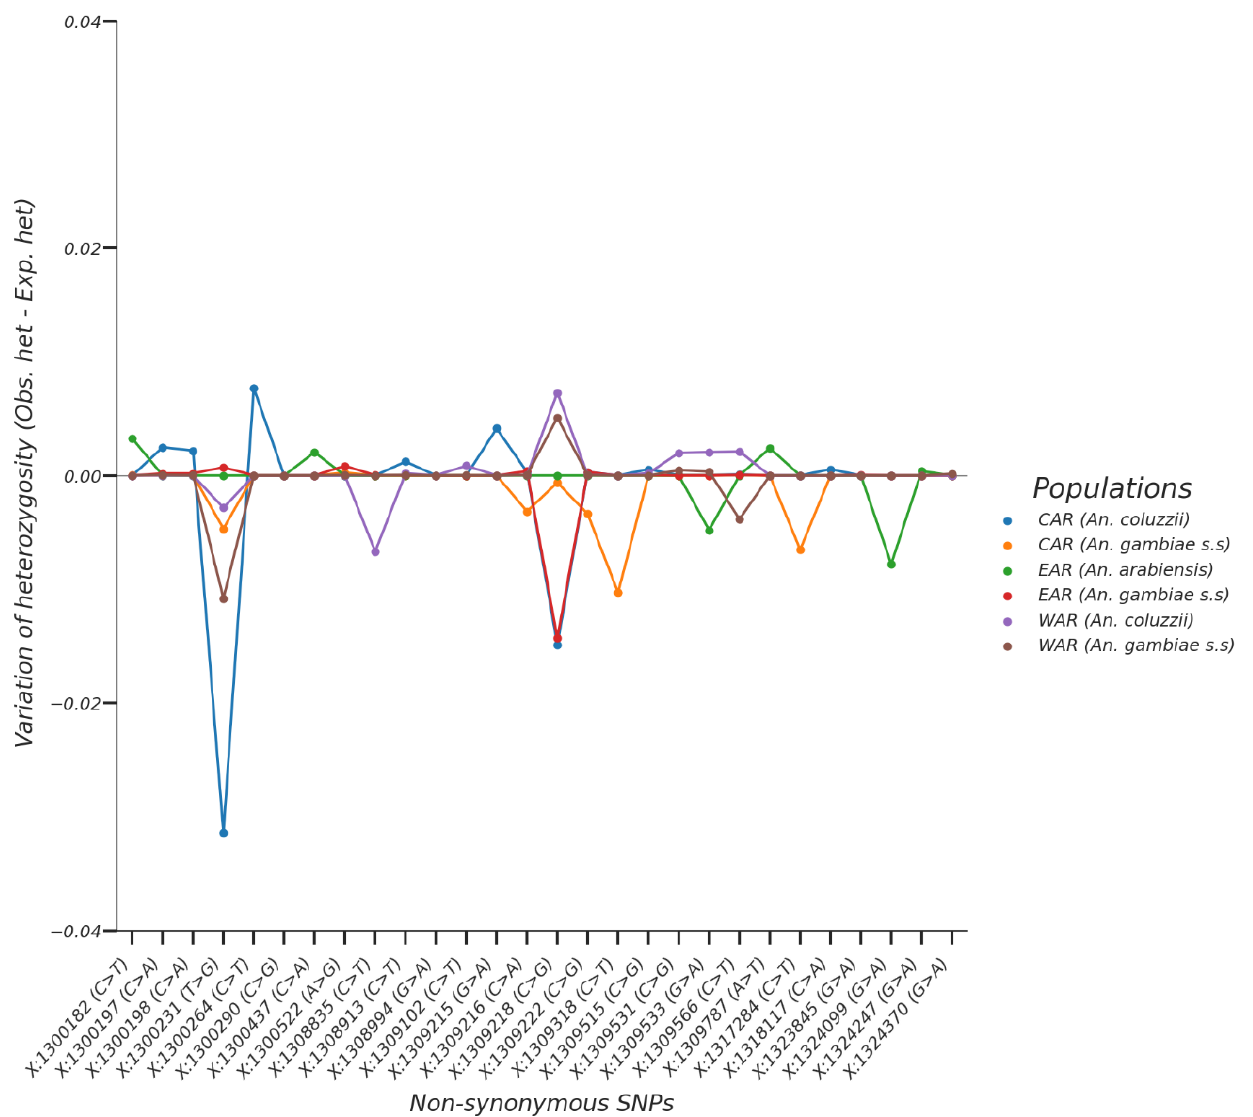
Figure 2. Variation of the heterozygosity within the non-synonymous SNPs with maximum allelic frequencies that are superior to 5% in at least one population of An. gambiae complex from West, Central, and East Africa. The vertical axis shows the difference between the observed and the expected heterozygosity; the horizontal axis shows the non-synonymous SNPs positions. Positive values (Obs. het > Exp. het) mean an excess of heterozygotes at this position; negative values (Obs. het < Exp. het) mean a deficit of heterozygotes at this position; null values (Obs. het = Exp. het) mean no deviation from the Hardy–Weinberg equilibrium at this position. Obs. het.: observed heterozygosity, Exp. het.: expected heterozygosity, CAR: Central African Region, EAR: Eastern African Region, WAR: Western African Region.